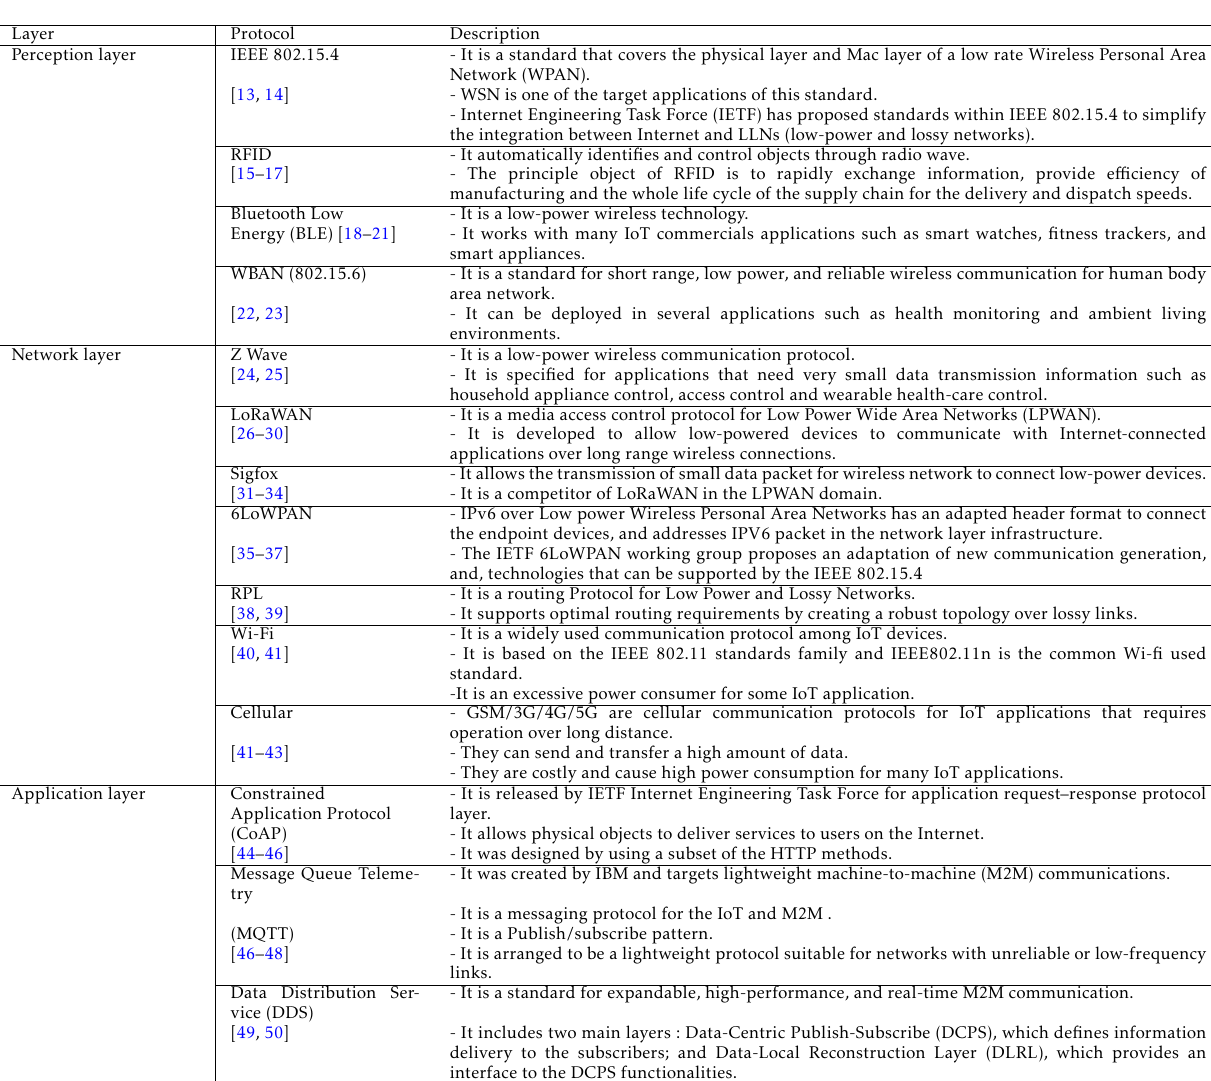
Table 1. IoT communication